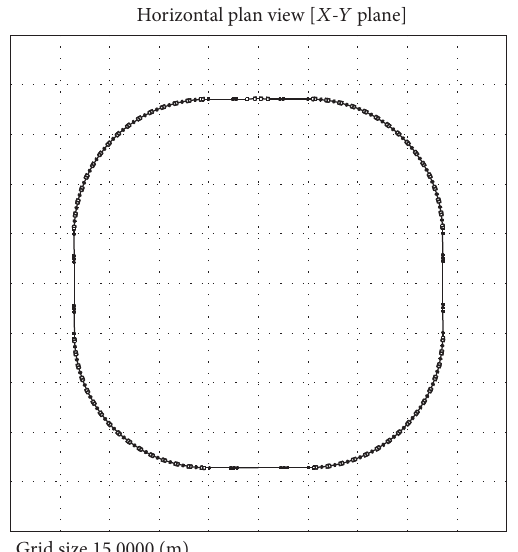
Figure 13: The layout of the lattice for the ESS accumulator.